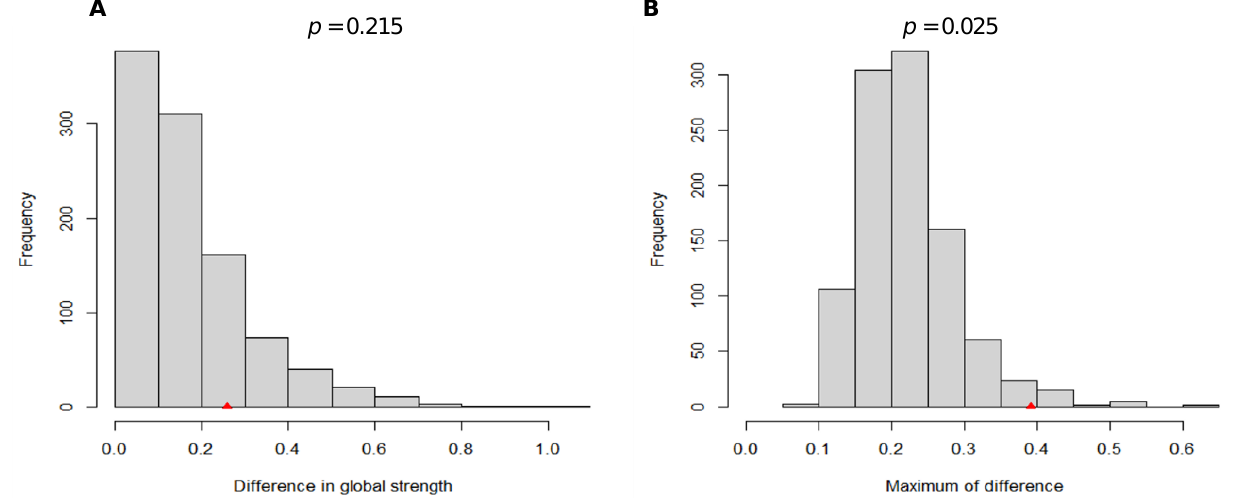
Figure 6. Comparison of network properties between wave 1 and wave 2 participants. Note ( A ) the plot of the bootstrap value of the difference in global network strength. ( B ) the plot of the bootstrap value of the maximum difference in any of the edge weights (1000 permutations).